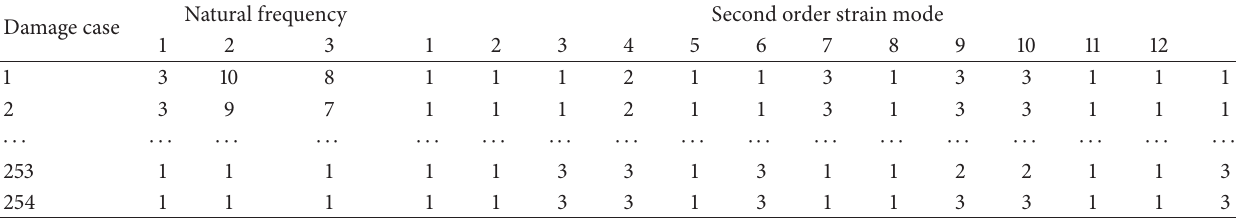
Table 11: Attribute set 2 rules generation for damage